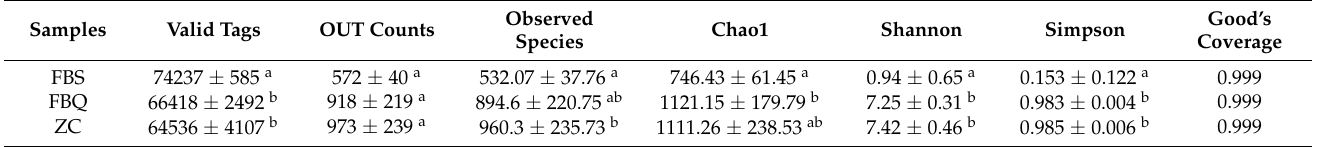
Table 2. Bacterial alpha diversity index of normal and spoiled Mianning